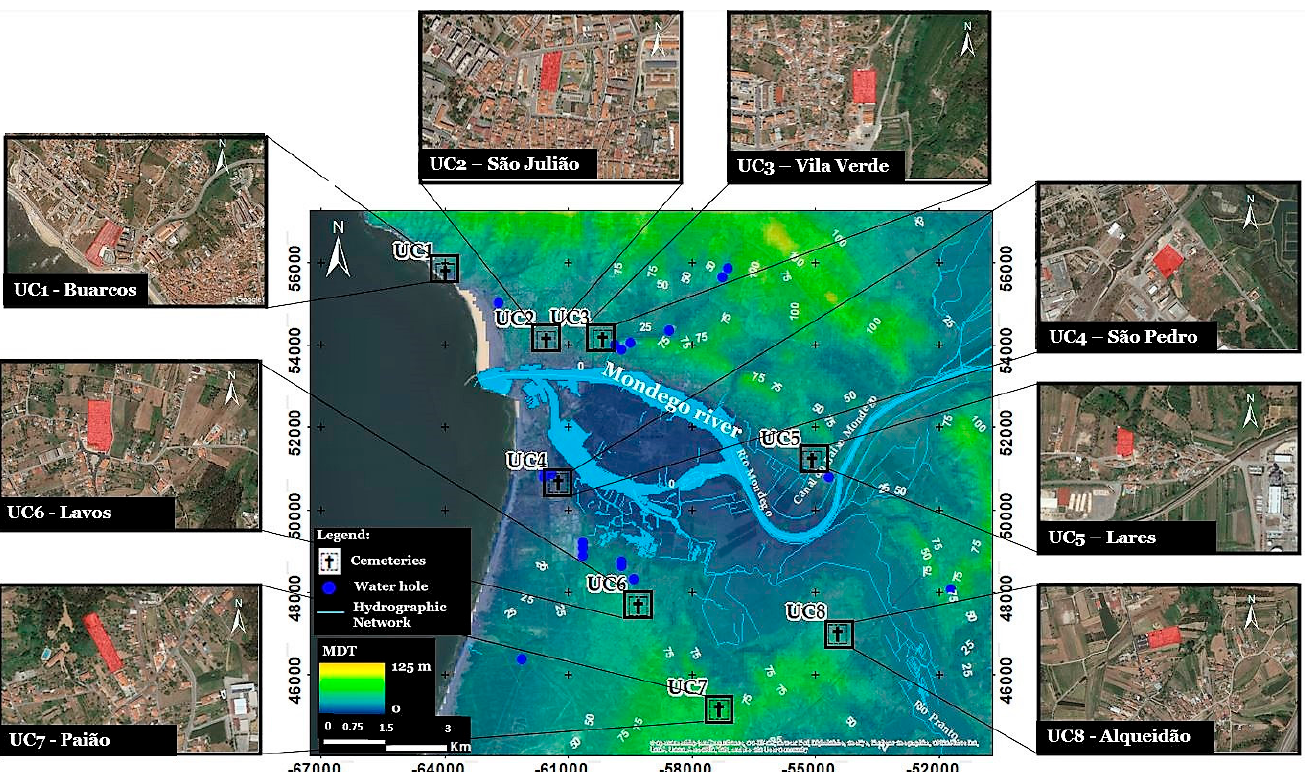
Figure 1. Geographic location of the eight cemeteries in the Figueira da Foz region.